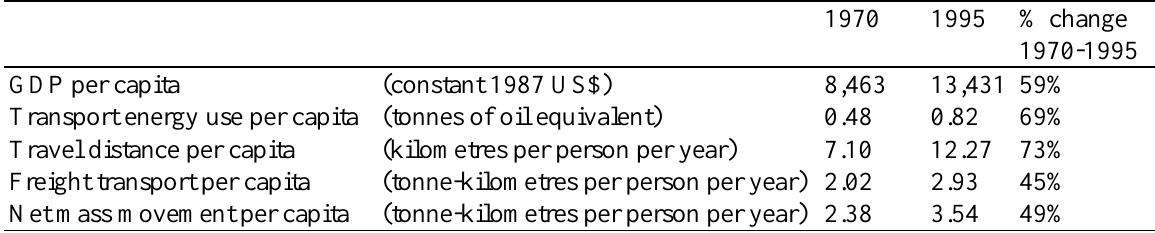
Table 5. Transport and Economic Trends in the UK,